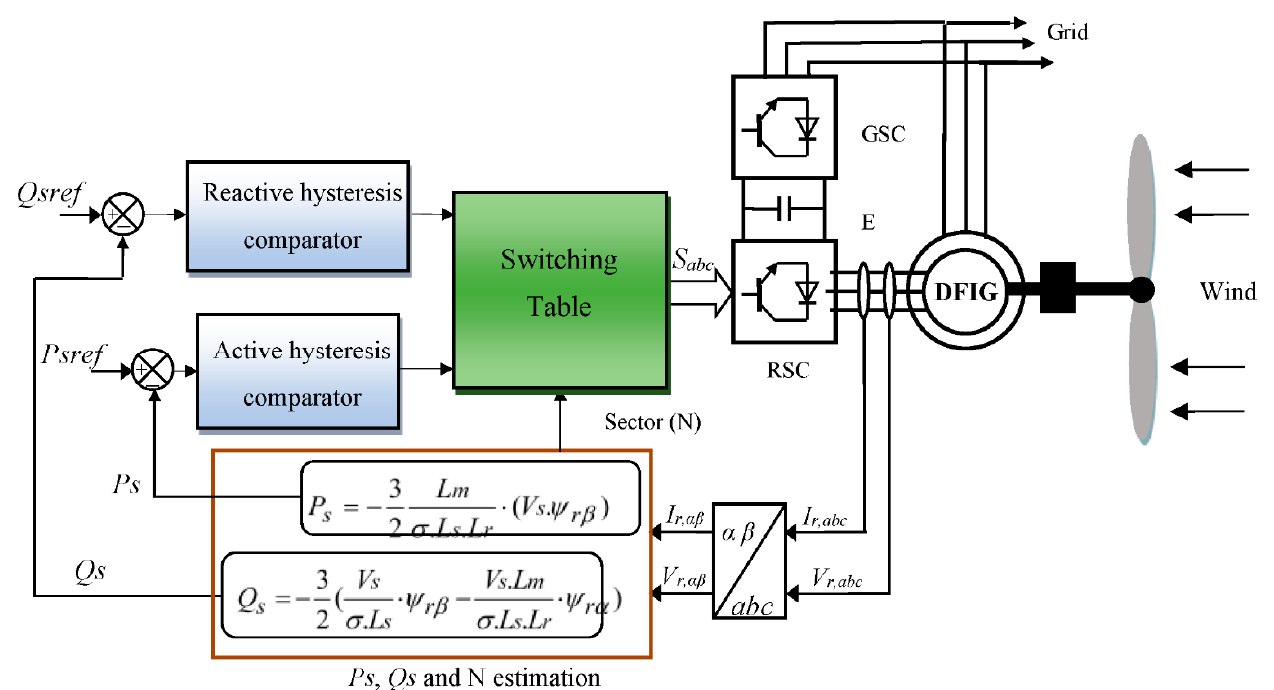
Figure 5. DPC of the RSC of the DFIG ‐ WT.